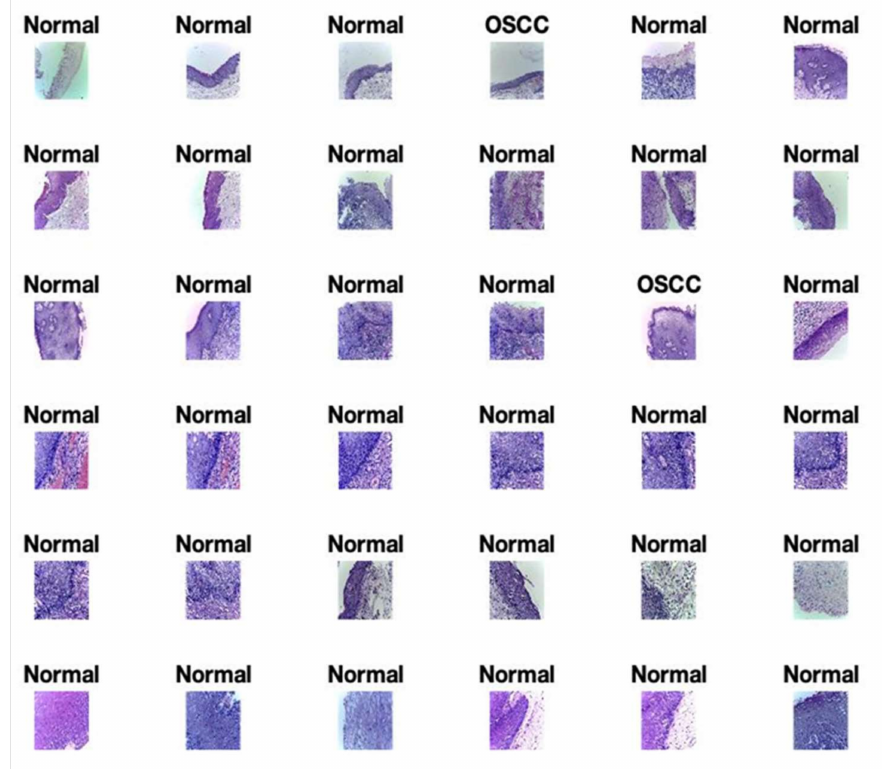
Figure 5. The proposed model predicted results of oral cancer during